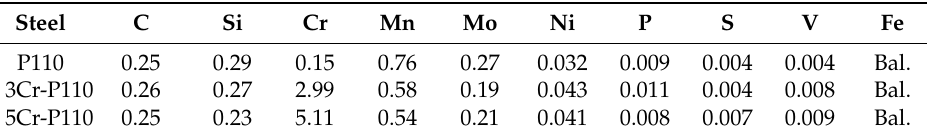
Table 1. Chemical compositions of the tested steels (wt